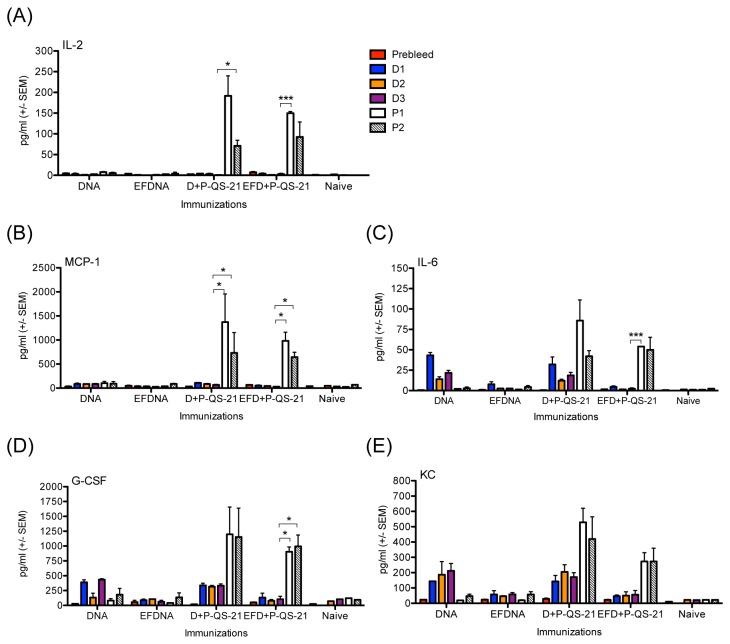
Temporal serum cytokine levels in mice immunized with endotoxin-free (EF) DNA prime compared to regular DNA plasmid preparation.Pentavalent gp120 DNA priming components were produced with either a regular or an EF DNA plasmid preparation kit. C57Bl/6 wild type mice were immunized with either three gp120 DNA primes and two “mock” saline boosts (‘DNA’ or ‘EF DNA’), or with three gp120 DNA primes and two gp120 protein boosts adjuvanted by QS-21 (‘D+P-QS-21’ or ‘EF D+P-QS-21’). Serum cytokines were quantified with a 12-plex Luminex panel in sera collected pre-immunization (‘Prebleed’), and at 6 hours after each of three DNA primes (‘D1,’ ‘D2,’ and ‘D3’) and two protein boost (‘P1,’ ‘P2’) immunizations. Shown are serum levels of (A) IL-2, (B) MCP-1, (C) IL-6, (D) G-CSF, and (E) KC. Statistical analysis was performed with a Student’s t test (*: p < 0.05, **: p < 0.01, ***: p < 0.001).